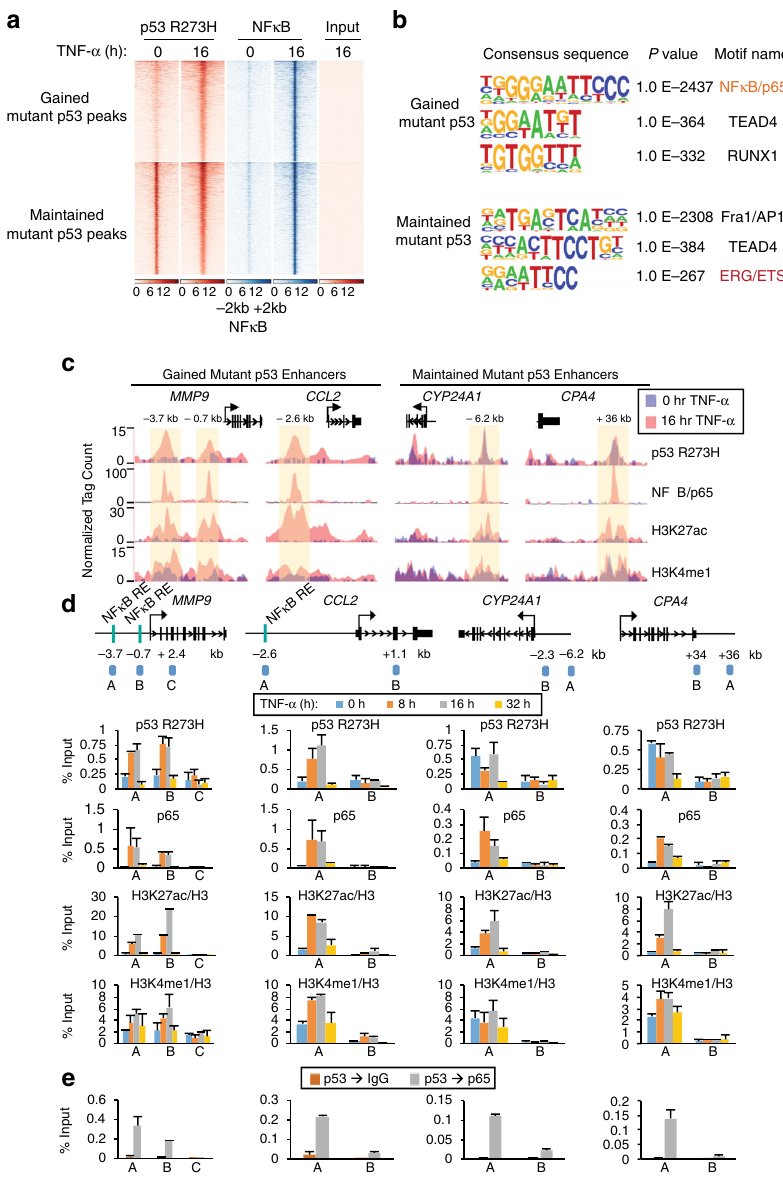
Fig. 2 Chronic TNF- α signaling alters mutp53 and NF κ B binding in colon cancer cells. a Heat maps of p53 R273H and NF κ B/p65 ChIP-seq reads in SW480 cells treated with TNF- α for 0 or 16 h. Each row shows ± 2 kb centered on p65 peaks, rank-ordered by the intensity of mutp53 and NF κ B/p65 peaks and grouped by gained versus maintained mutp53 peaks. b De novo motif analyses of the TNF-gained and maintained mutp53 overlapping NF κ B/p65 binding sites as noted in ( a ). c UCSC genome browser tracks of ChIP-seq signals for p53 R273H, NF κ B/p65, H3K27ac, and H3K4me1 at the MMP9 , CCL2 , CYP24A1 , and CPA4 gene loci in untreated (purple) or TNF- α 16 h (pink)-treated SW480 cells. The y axis depicts the ChIP-seq signal and the x axis locates the genomic position with the enhancer regions highlighted in yellow. d Schematics of ChIP-qPCR amplicons and ChIP analyses with the indicated antibodies at the enhancers and non-speci fi c regions of MMP9 , CCL2 , CYP24A1 , and CPA4 gene loci. ChIP-qPCR amplicons were designed to amplify the enhancer (A and B at MMP9 and A at CCL2 , CYP24A1 , and CPA4 ) or non-speci fi c (C at MMP9 and B at CCL2 , CYP24A1 , and CPA4 ) regions of the target gene loci. ChIP experiments were performed using SW480 cells treated with TNF- α for 0, 8, 16, and 32 h. ChIPs for histone marks were normalized to H3. An average of two independent ChIP experiments that are representative of at least three is shown with error bars denoting the standard error. e Sequential ChIP (re-ChIP) with p53 antibody followed by IgG (control) and NF κ B/p65 antibody performed in SW480 cells treated with TNF- α for 16 h. The ChIP-qPCR amplicons are identical to those used in ( d ). An average of two independent re-ChIP experiments that are representative of at least three is shown with error bars denoting the standard